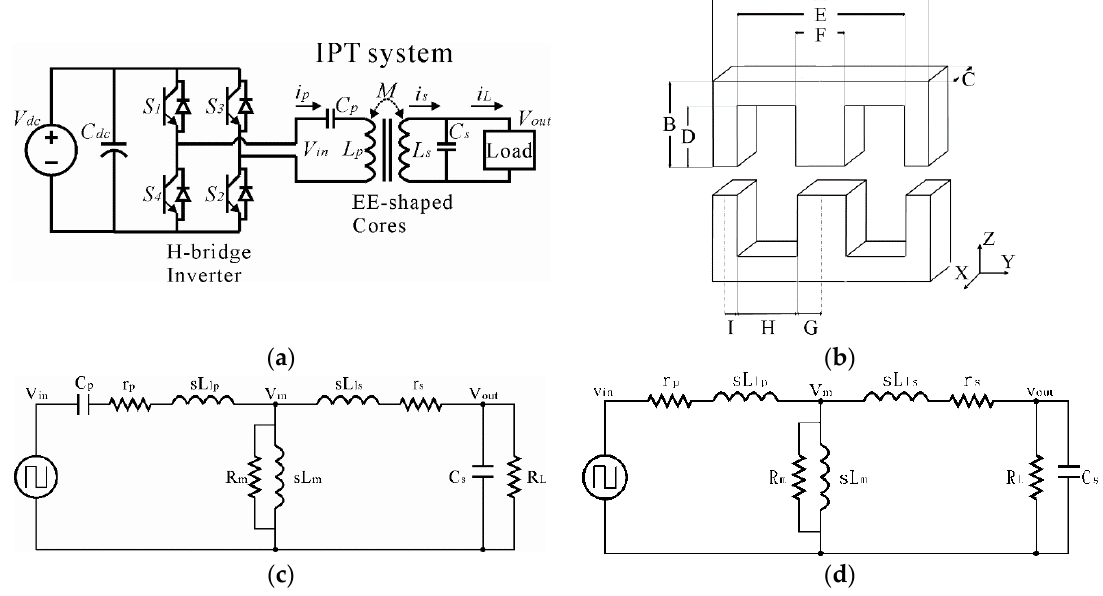
Figure 2. Simplified inductive power transfer system. ( a ) Circuit of the IPT system; ( b ) EE ‐ shaped cores; ( c ) Equivalent circuit of the SP topology; ( d ) Equivalent circuit of the P topology.